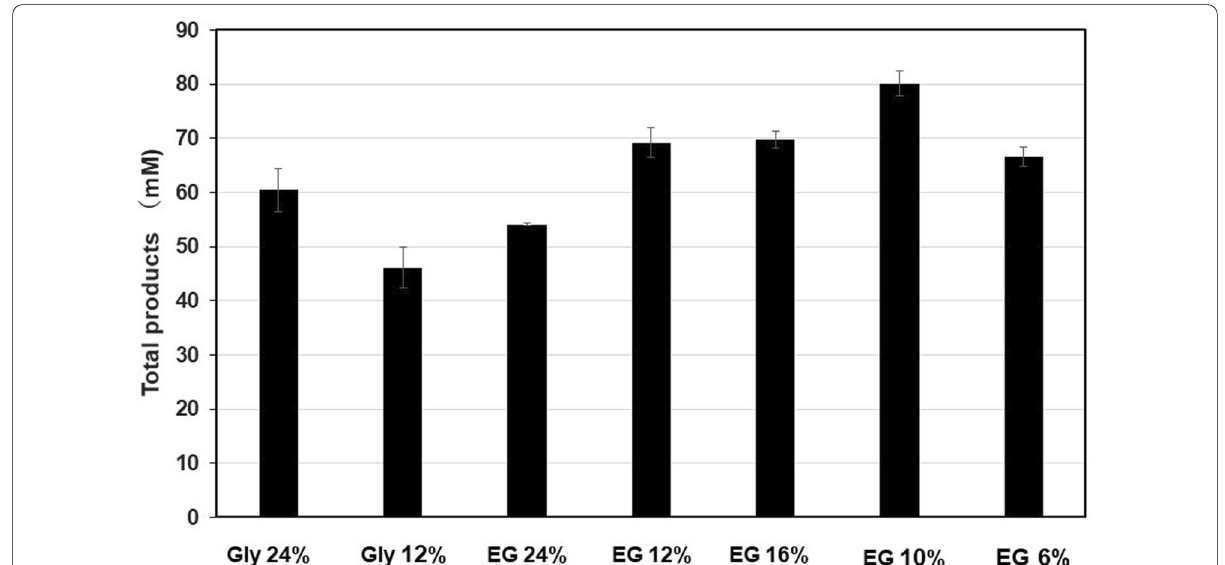
Fig. 5 Effect of glycerol and ethylene glycol on the enzyme activity. The reactions were conducted with PET powder 2 (20 mg/ml) using Cut190**SS at 65 °C for 1 day under the assay conditions described in “Materials and methods” expect that glycerol or ethylene glycol were used at the concentrations indicated and dodecetyltrimethylammonium chloride was added at 50